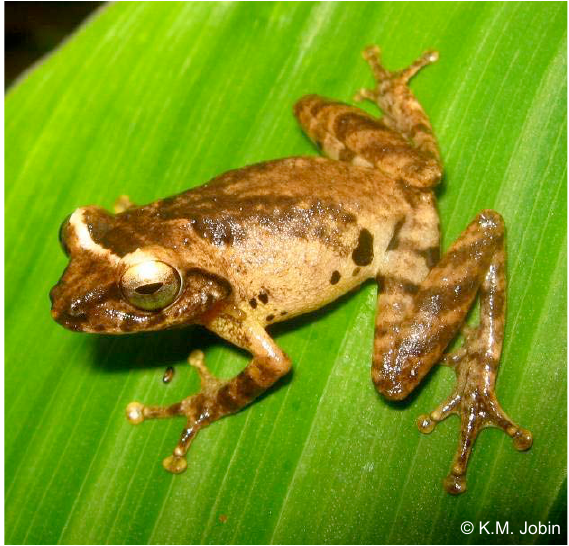
Table 1) with a bright green dorsum. Green coloration